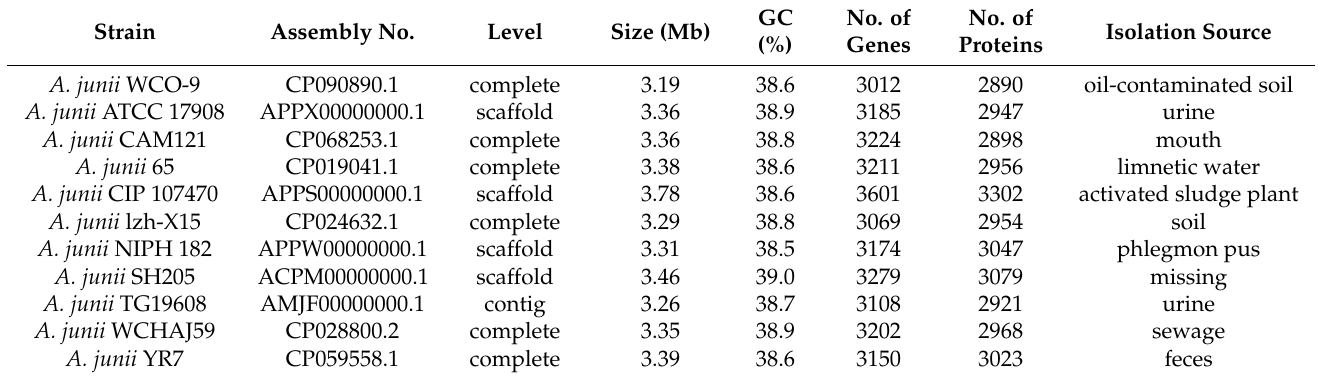
Table 2. General features of A. junii genomes used in this study.